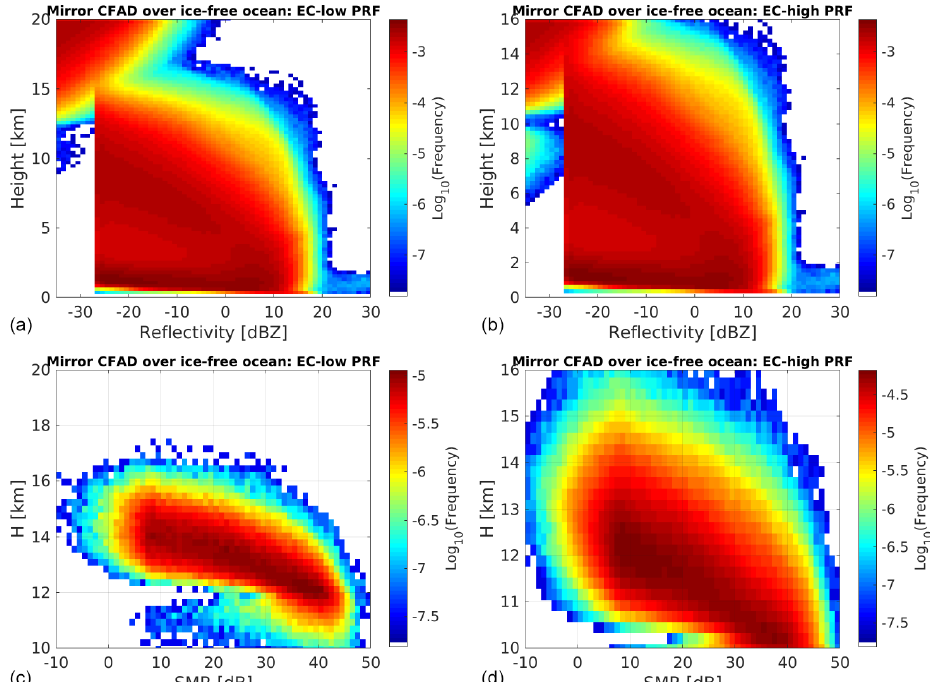
Figure 8. Expected impact of second-trip echoes generated by mirror images in EC observations. (a, b) Simulated CFAD of reflectivities for the low-PRF (a, c) and high-PRF (b, d) EarthCARE configurations. (c, d) Same as (a) and (b) for simulated CFAD of signal-to-mirror ratios